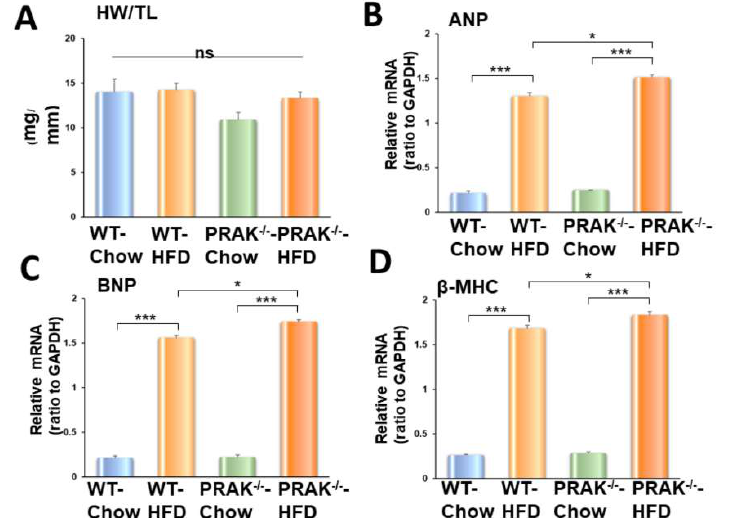
Figure 4. Depletion of PRAK enhances hypertrophic gene expression in mice exposed to HFD. ( A ): Heart weight/tibia length ratio. Data are shown as means ± SEM ( n = 5/each group). ( B ): Atrial natriuretic peptide (ANP); ( C ): B-type natriuretic peptide (BNP); ( D ): Myosin heavy chain beta ( β -MHC); Data are shown as means ± SEM ( n = 3–4/each group). * p < 0.05 *** p <